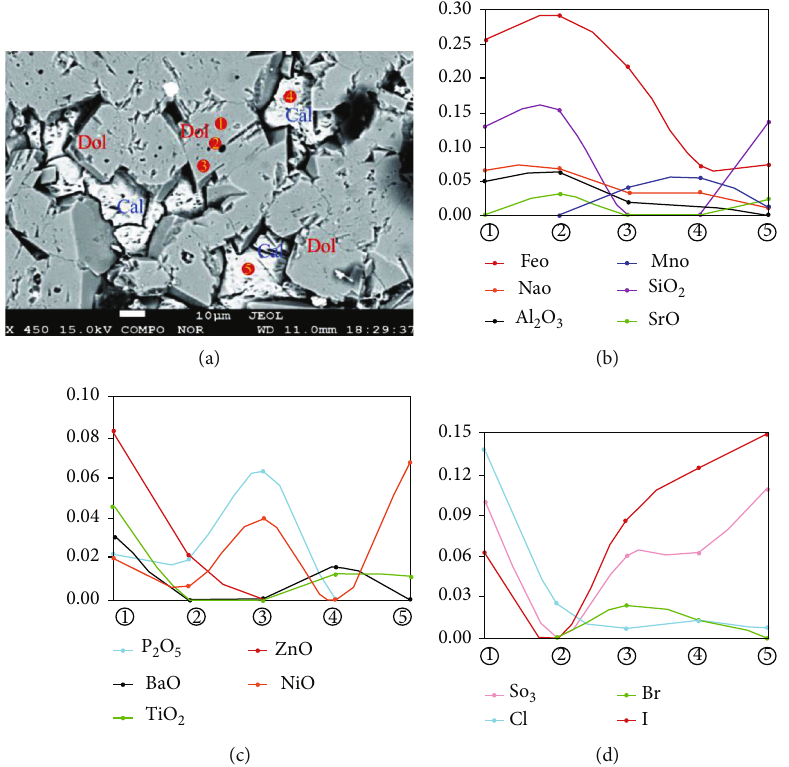
Figure 11: Electron microprobe images and element content variations for the powder- fi ne dolomite in well